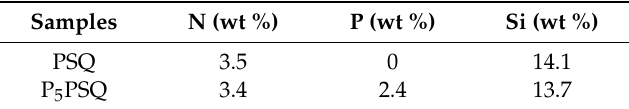
Table 1. Elemental compositions of PSQ and P 5 PSQ.